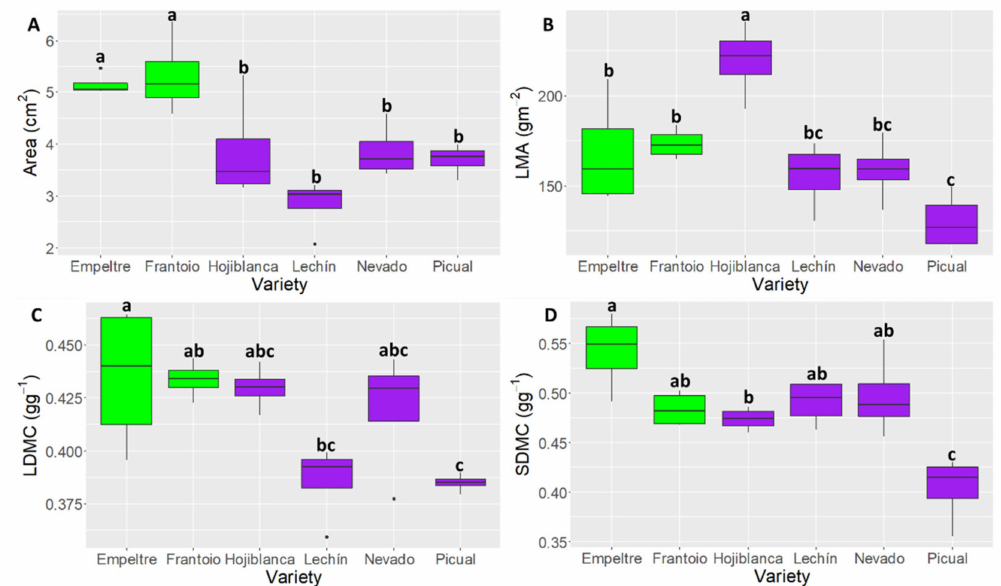
Figure 1. Boxplots showing median values of Area (‘leaf area’) ( A ), LMA (‘Leaf mass per area’) ( B ), LDMC (‘Leaf dry matter content’) ( C ) and SDMC (‘Stem dry matter content’) ( D ). Tolerant cultivars are represented in green color while the susceptible ones are shown in purple color. Letters indicate Tukey HSD post hoc tests at the p < 0.05 level, following